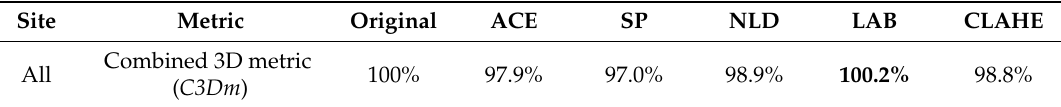
Table 11. Average metrics and average expert vote calculated for each site.